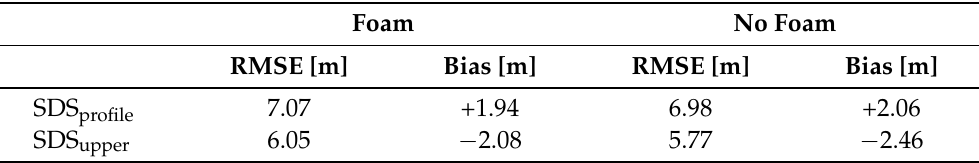
Table 8. Time and beach averaged RMSE and bias for each of the presented methodologies, for all the AoI (Foam) and without the AoI with foam (No